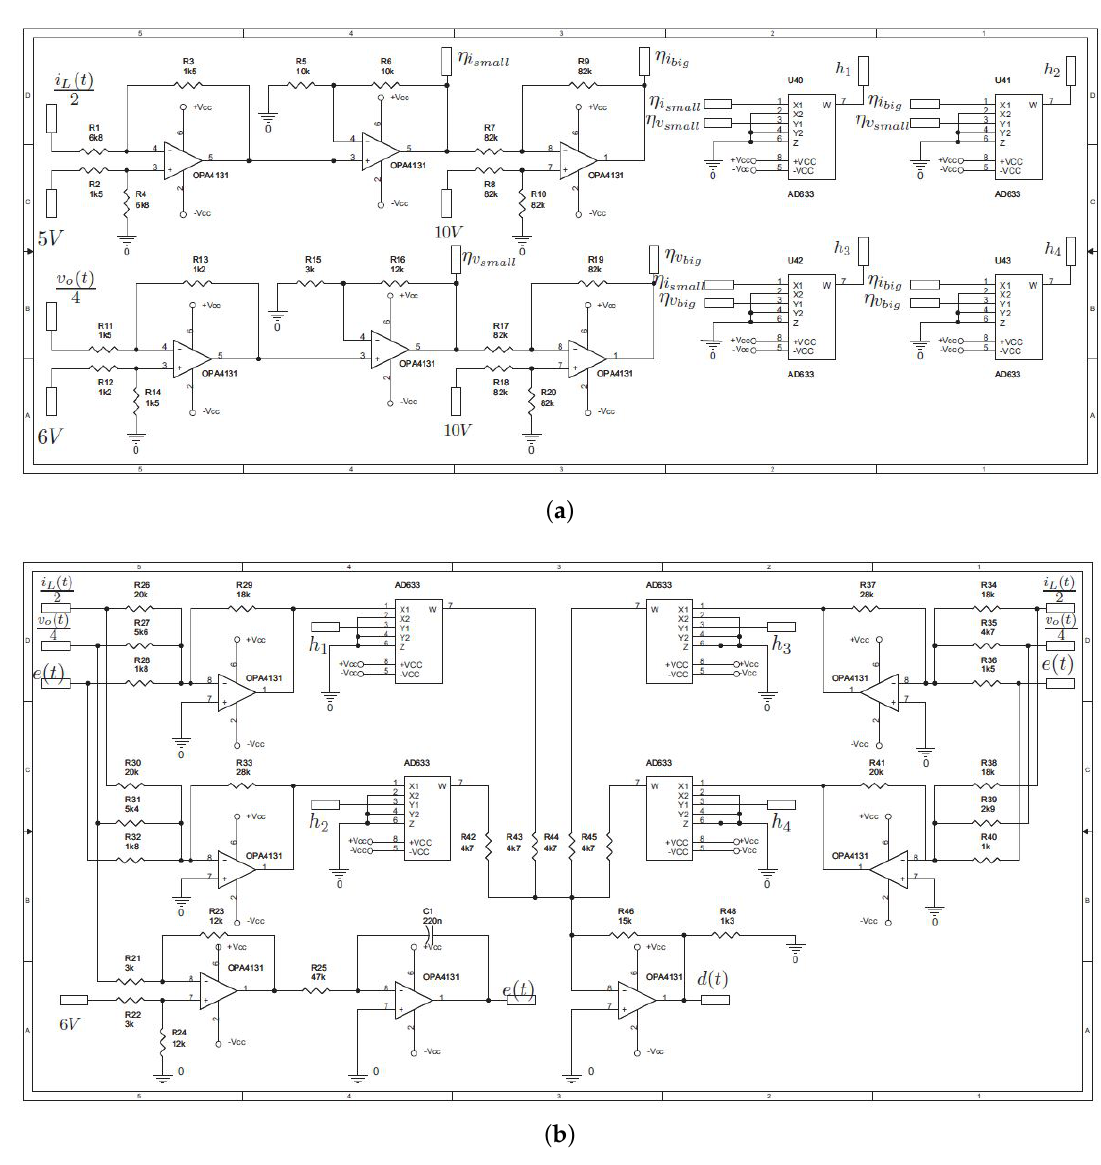
Figure 13. Detailed circuit implementation of the LMI-Fuzzy Control. ( a ) Circuit diagram for the calculate membership functions and normalized weights. ( b ) Circuit diagram for the calculate total T-S fuzzy